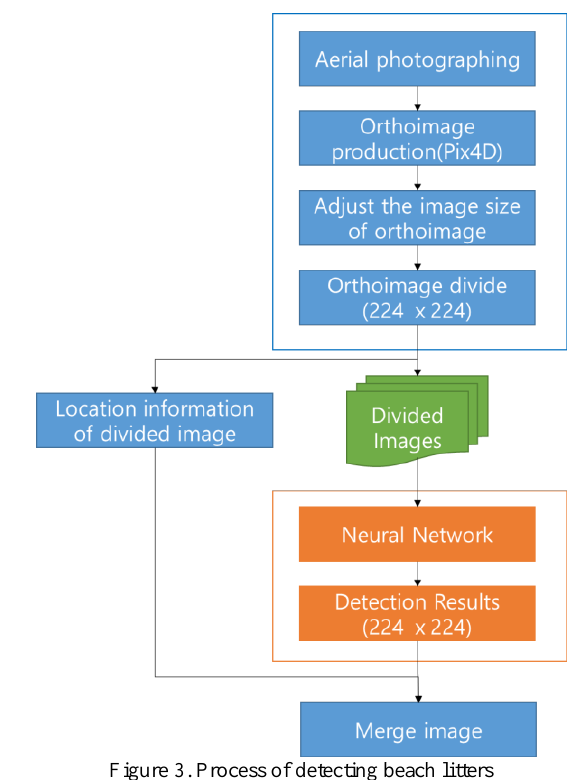
Figure 3. Process of detecting beach